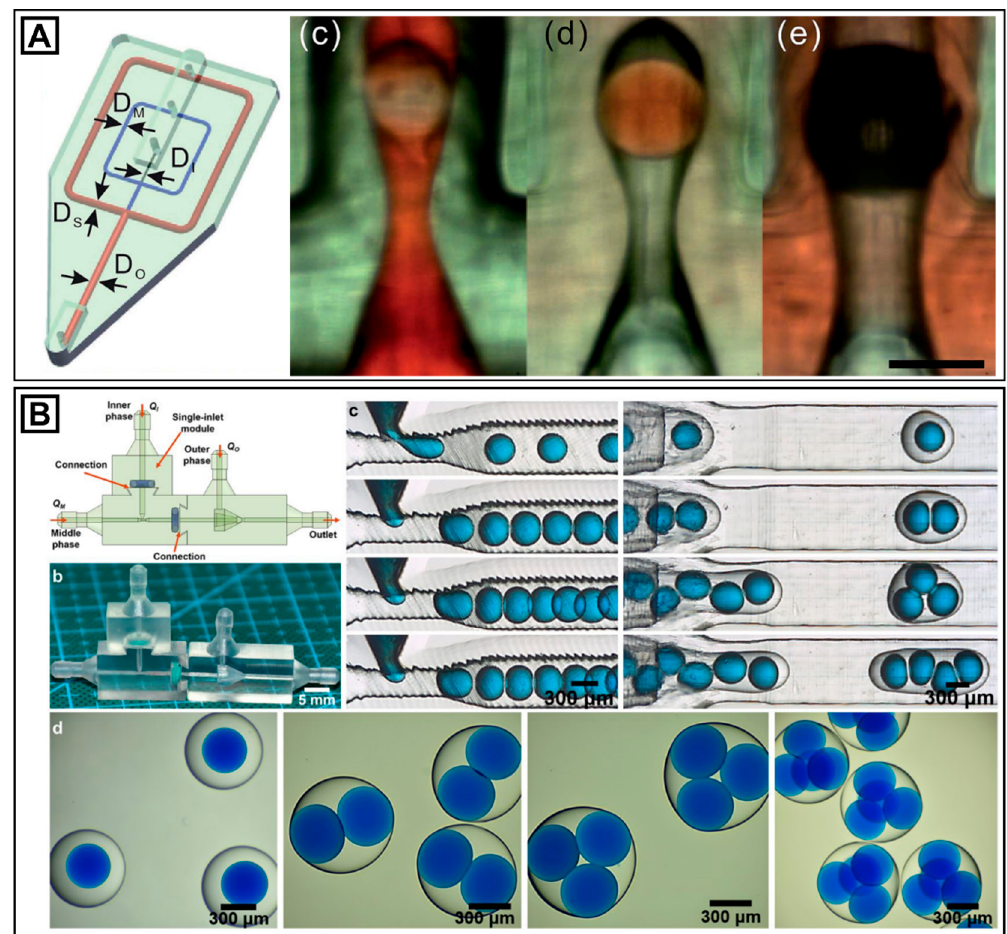
Figure 5. 3D-printed microfluidic devices for forming double emulsions. ( A ) Nonplanar microfluidic device design for producing oil-in-water-in-oil, water-in-oil-in-water, or air-in-oil-in-water emulsions. Adapted with permission from Thoroddsen et al. [176] ( B ) Device for forming double emulsions, assembled from 3D-printed flow cell modules. The number of encapsulated liquid cores could be tuned by adjusting the flow rates. Adapted with permission from Duan et al. [80].